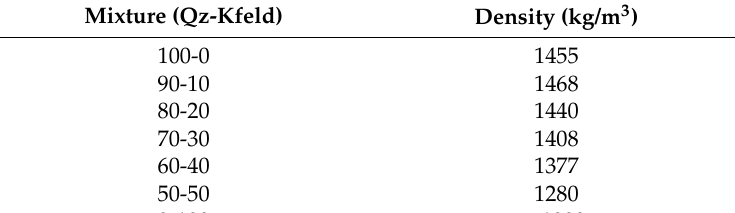
Table 4. Density values for the different granular mixtures.